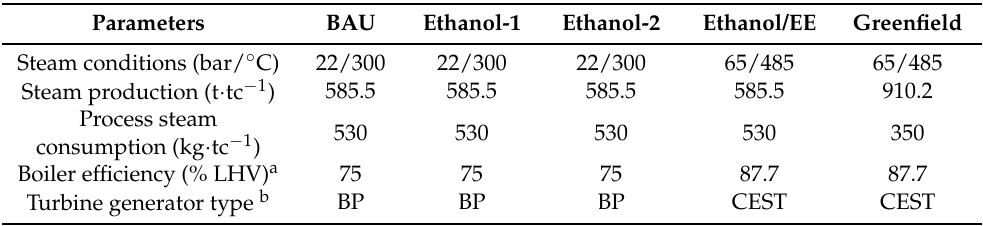
Table 3. Technical coefficients (parameters) to the simulated scenarios.